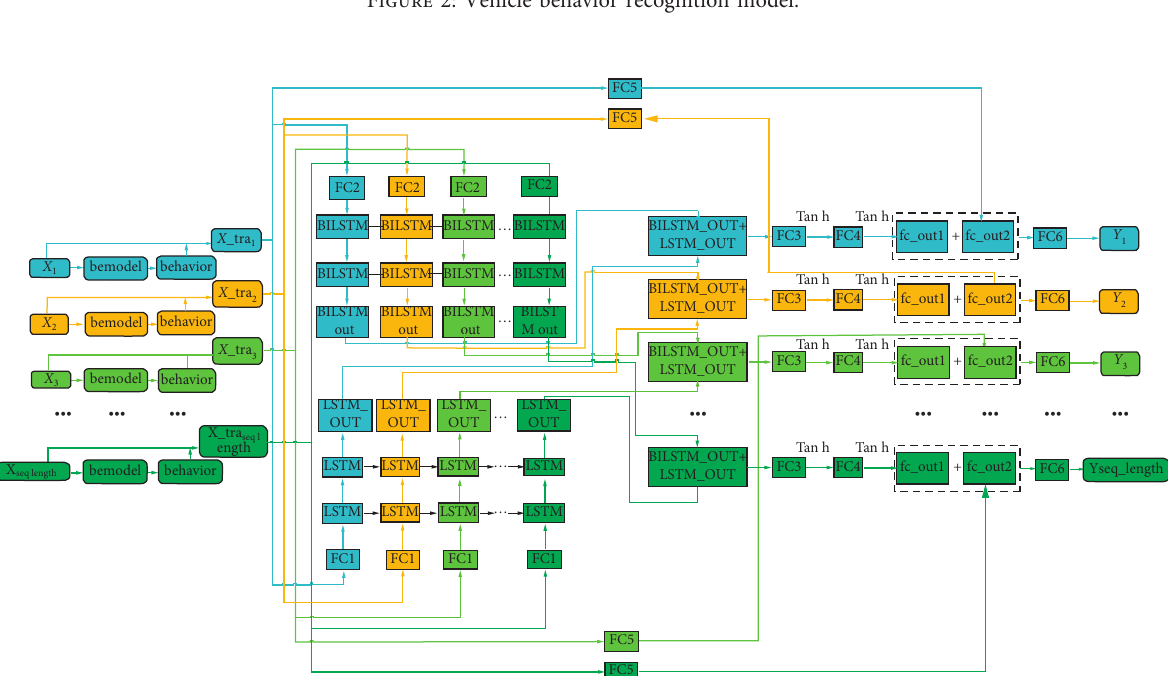
Figure 3: Trajectory prediction model.